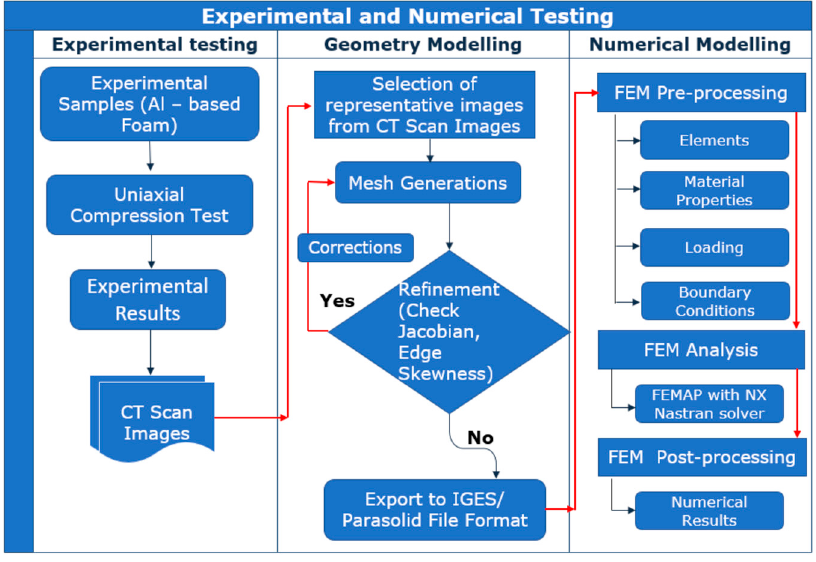
Figure 1. Schematic representation of steps in experimental and numerical study.